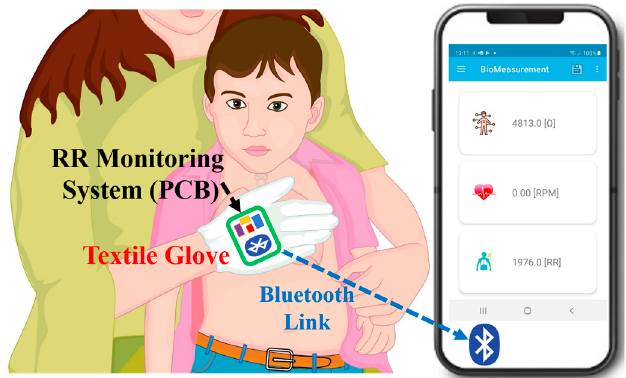
Figure 1. Proposed novel RR monitoring system for infants based on textile glove and dry electrodes.